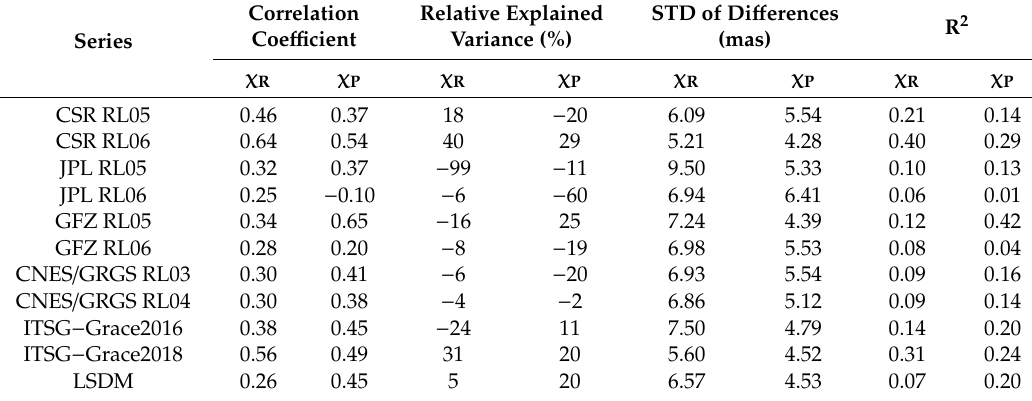
Table A4. Correlation coe ffi cients of χ R and χ P parts of short-term ( < 730 days) non-seasonal variation between GAO and HAM computed from GRACE solutions and LSDM model, the percentage of variance in GAO explained by HAM functions, standard deviation (STD) of di ff erences between GAO and HAM, and coe ffi cient of determination (R 2 ). The critical value of the correlation coe ffi cient for 25 independent points and a confidence level of 0.95 was 0.34. The standard error of the di ff erence between two correlation coe ffi cients for 25 independent points was